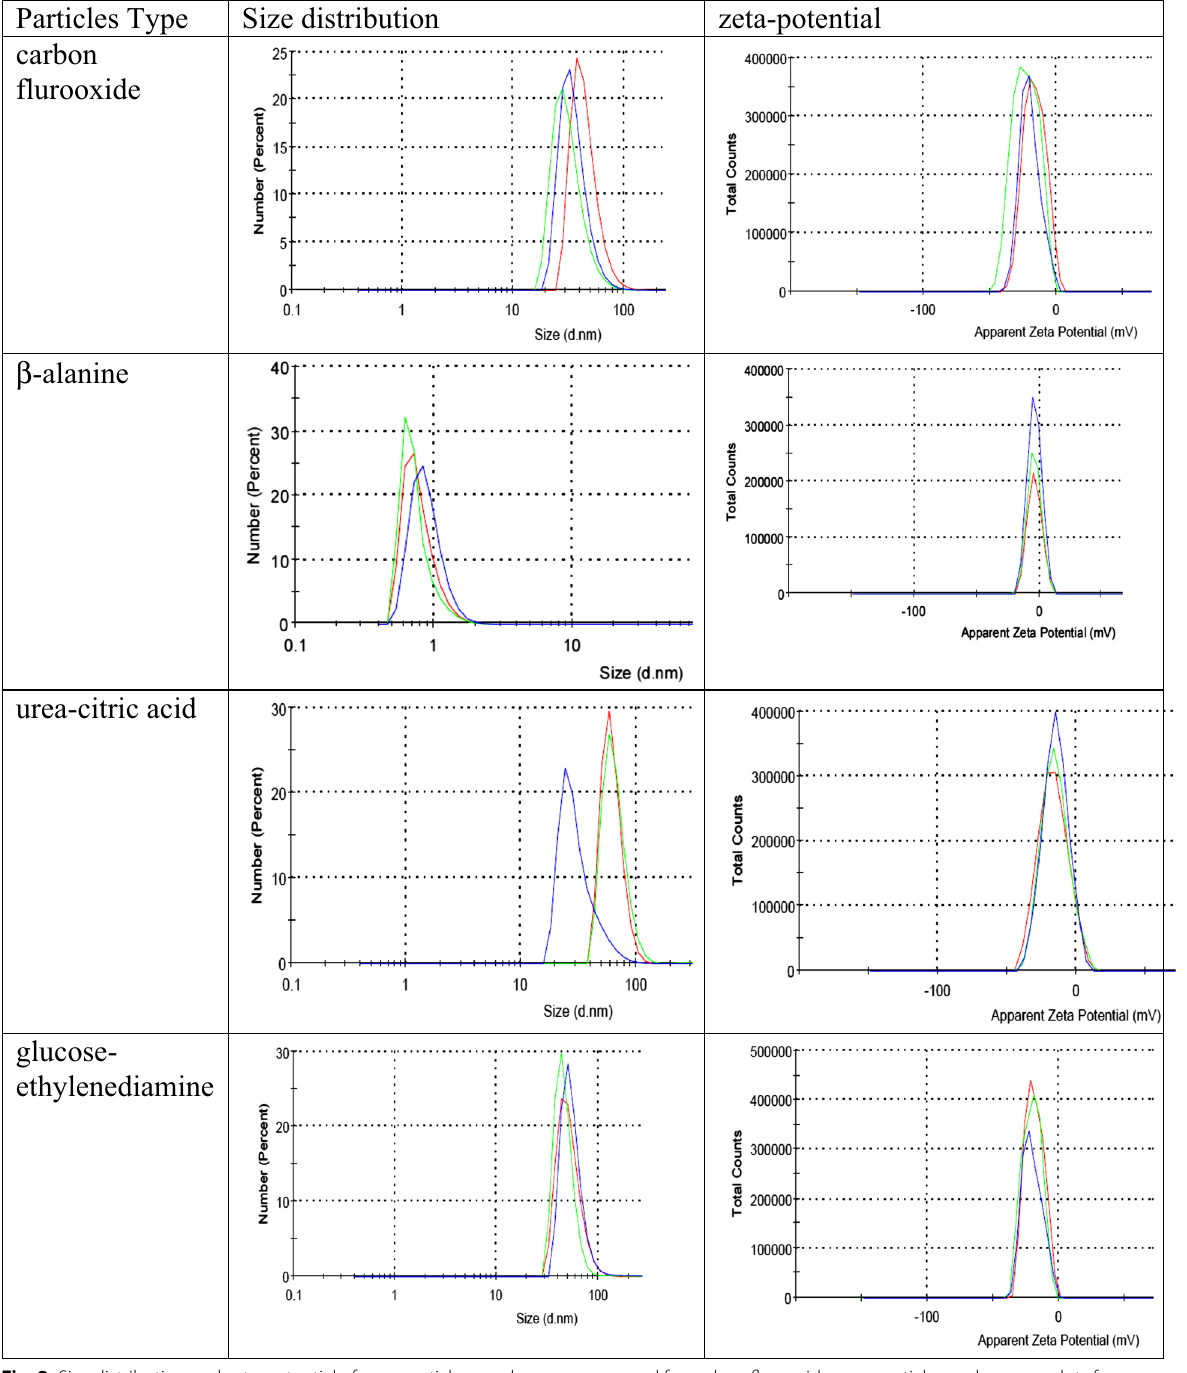
Fig. 2 Size distribution and zeta-potential of nanoparticle samples were measured for carbon flurooxide nanoparticles, carbon nanodots from β -alanine, carbon nanodots from urea-citric acid, and glucose-ethylenediamine nanoparticles. Each measurement was carried out during 1 min. Red line: first measurement, green line: second, blue line: